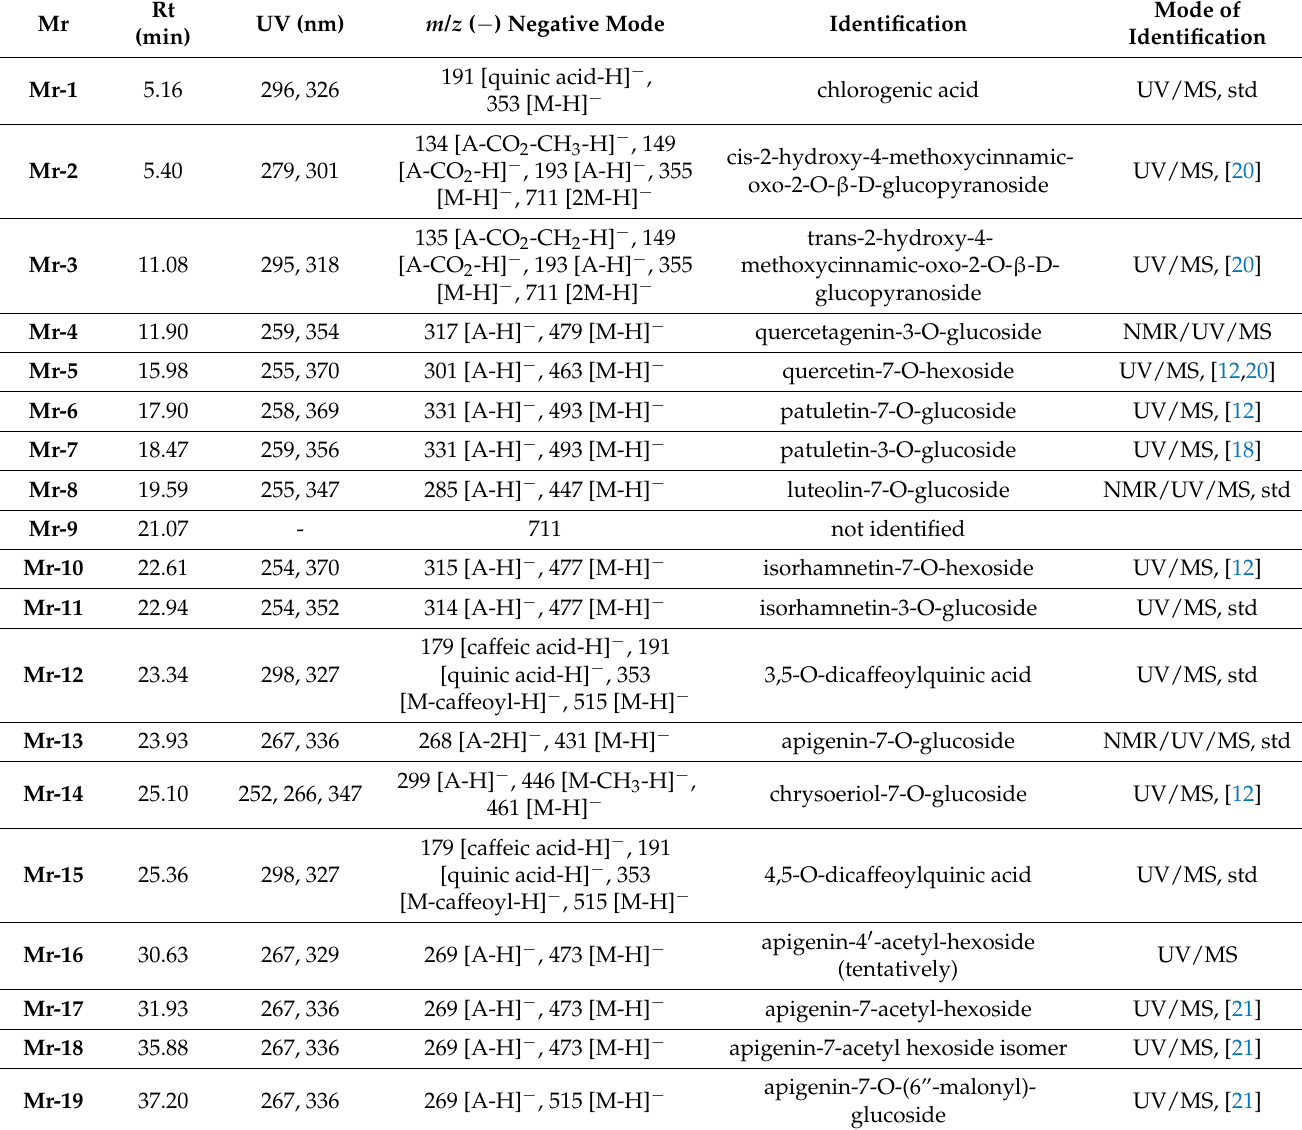
Table 2. MS fragmentation and UV–vis absorption data of the compounds detected in the methanol extract of Matricaria recutita